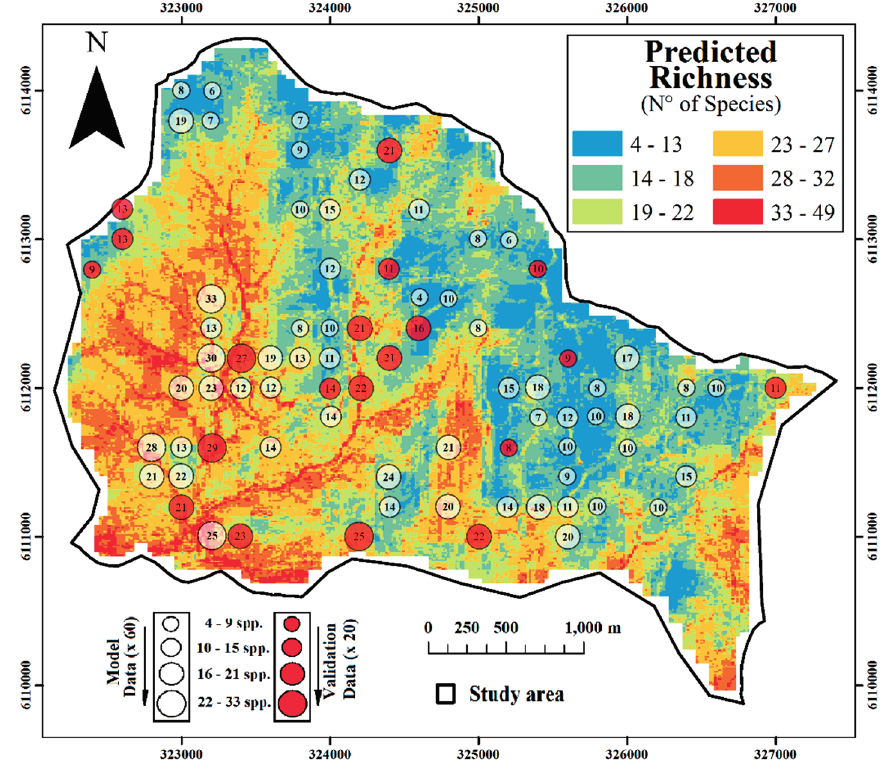
Figure 5. Spatialization of the predictive model of plant vascular richness. White circles depicted the richness value of the sampling plot used for the model construction. Red circles depicted the richness values of the sampling plots used for validation